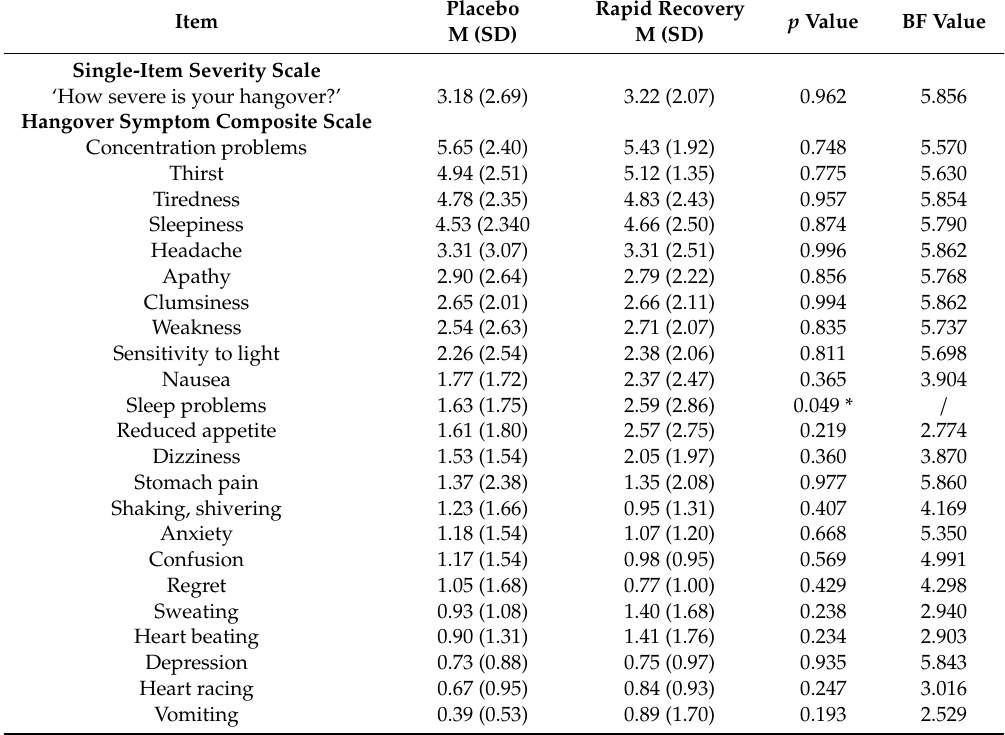
Table 1. Hangover symptom severity scores (means and standard deviations) in the Rapid Recovery and placebo conditions. Descriptive data is given in the left columns, while the p value obtained from paired samples t-tests and the Bayes factor (BF) value obtained in case of non-significant di ff erences (i.e., p values < 0.05) are provided in the right